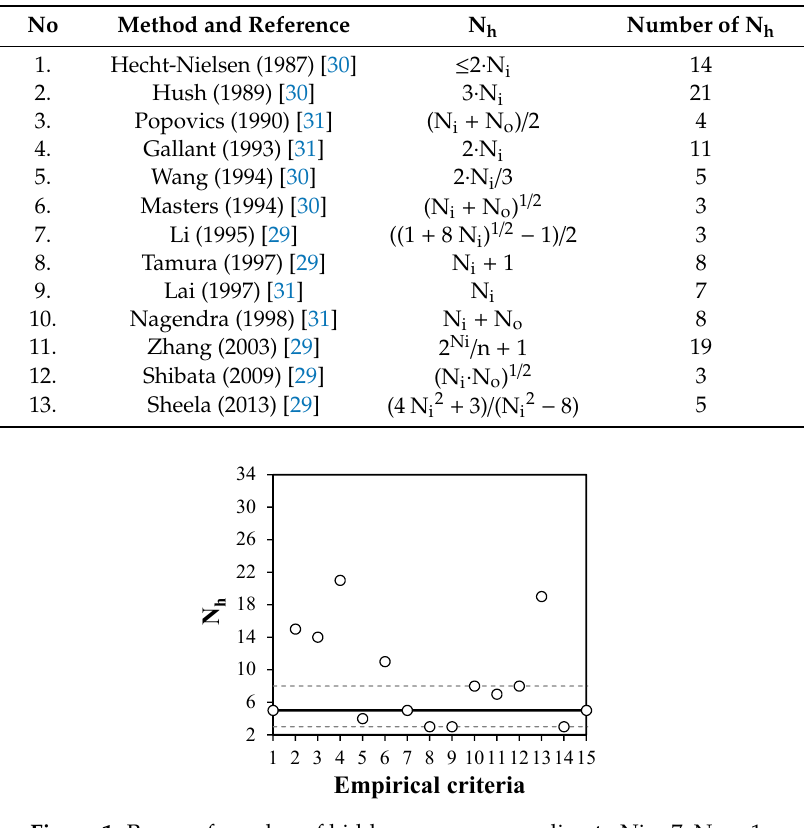
Figure 1. Range of number of hidden neurons according to Ni = 7, No = 1.